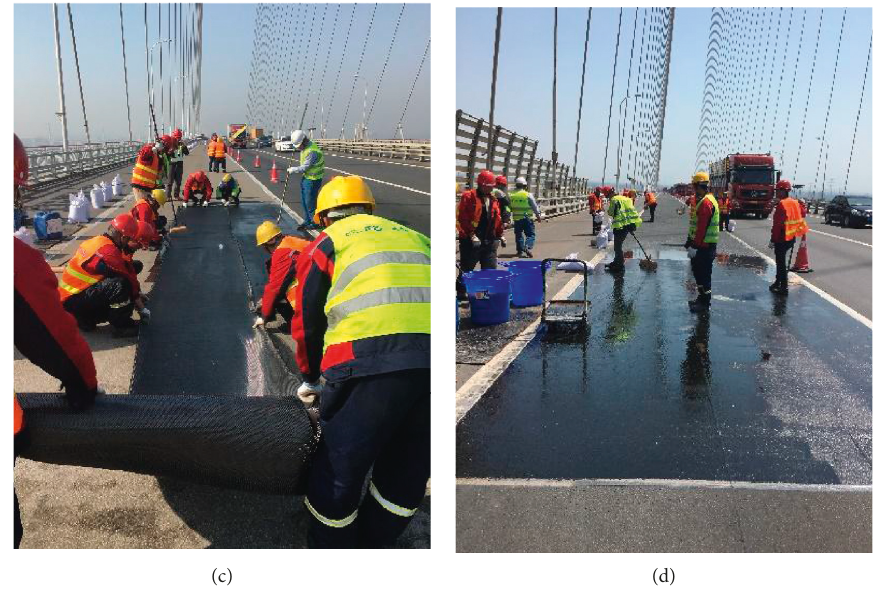
Figure 20: Construction technology of the thin overlay of fiber-reinforced resin on the Suzhou–Nantong Bridge.